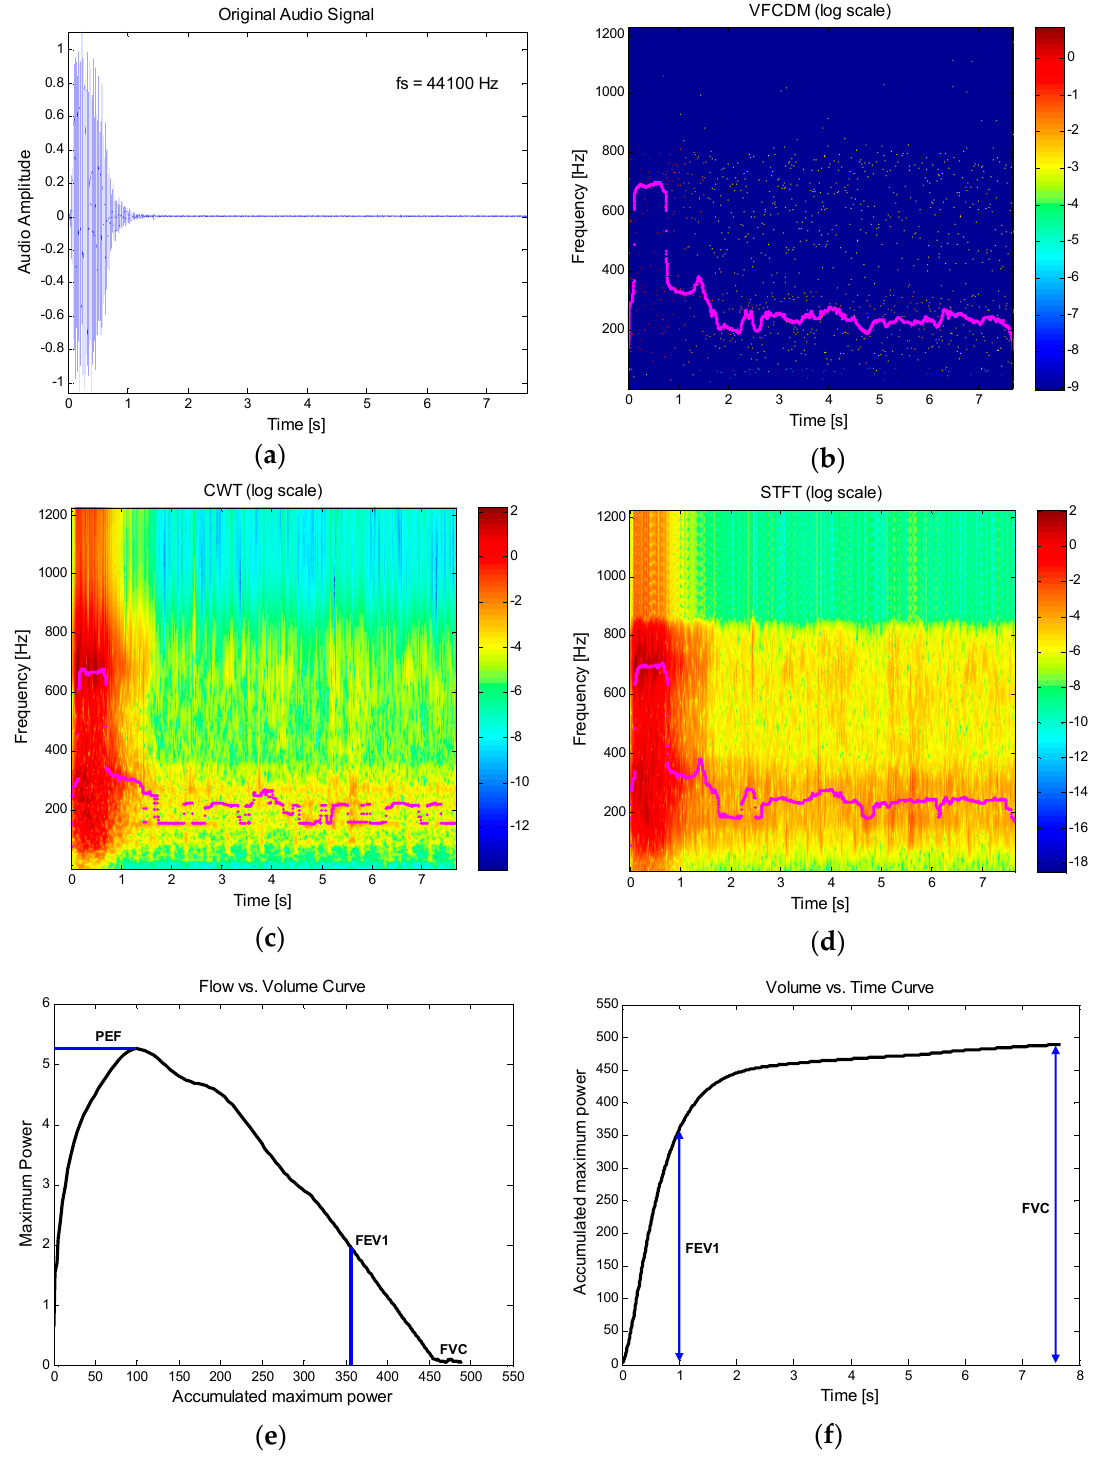
Figure 3. Main procedure to obtain flow-volume curve and volume-time curve from healthy subjects and comparison of VFCDM, CWT, and STFT: ( a ) original audio signal; ( b ) resultant time-frequency spectrum from VFCDM; ( c ) resultant time-frequency spectrum from CWT; ( d ) resultant time-frequency spectrum from STFT; ( e ) maximum power vs. accumulated maximum power from VFCDM; and ( f ) accumulated maximum power vs. time from VFCDM.